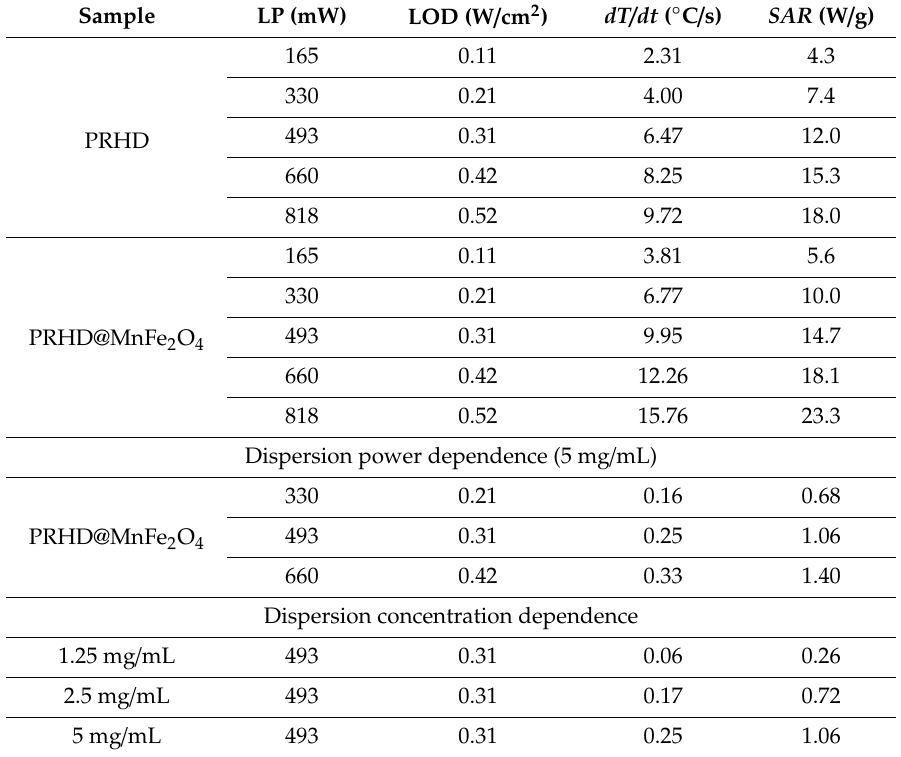
Figure 8. Specific heat capacities of PRHD and PRHD@MnFe 2 O 4 samples measured at the temperature range of 20–50 ◦ C ( left ) and LOD dependence on SAR values ( right ). * SAR calculated for the whole system. Table 1. Specific absorption rate ( SAR ) calculated for dry PRHD and PRHD@MnFe 2 O 4 powders and colloidal suspensions of hybrids.